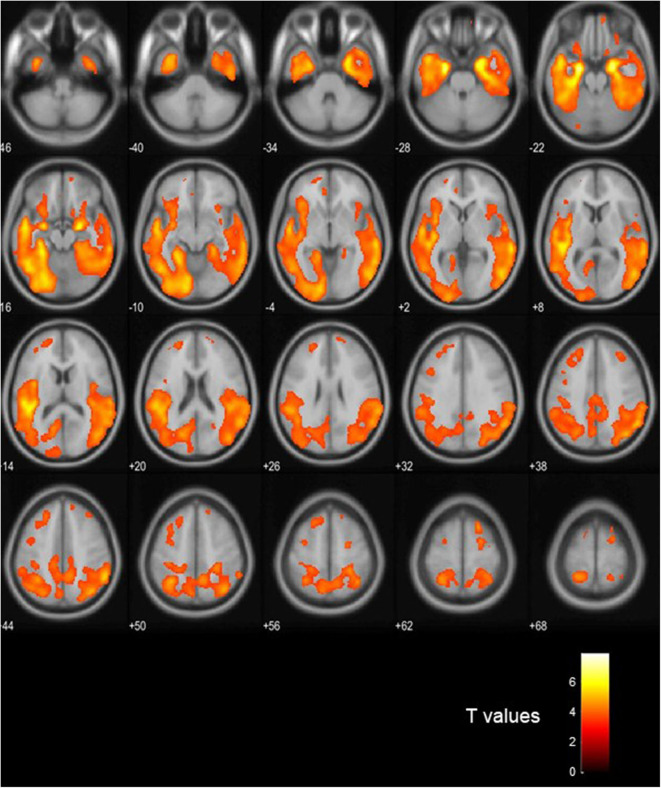
Visualization of the voxel-based [18-F]AV1451 PET tau analysis. The colors signify the regions with increased [18-F]AV1451 signal in the FTLD-AD group, compared to the FTLD-non-AD group (uncorrected p < 0.001; extent threshold, k = 50).